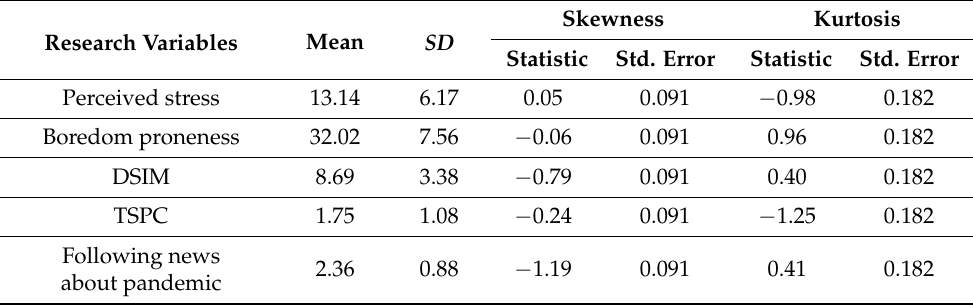
Table 2. Descriptive statistics of research variables—mean, SD, skewness, and